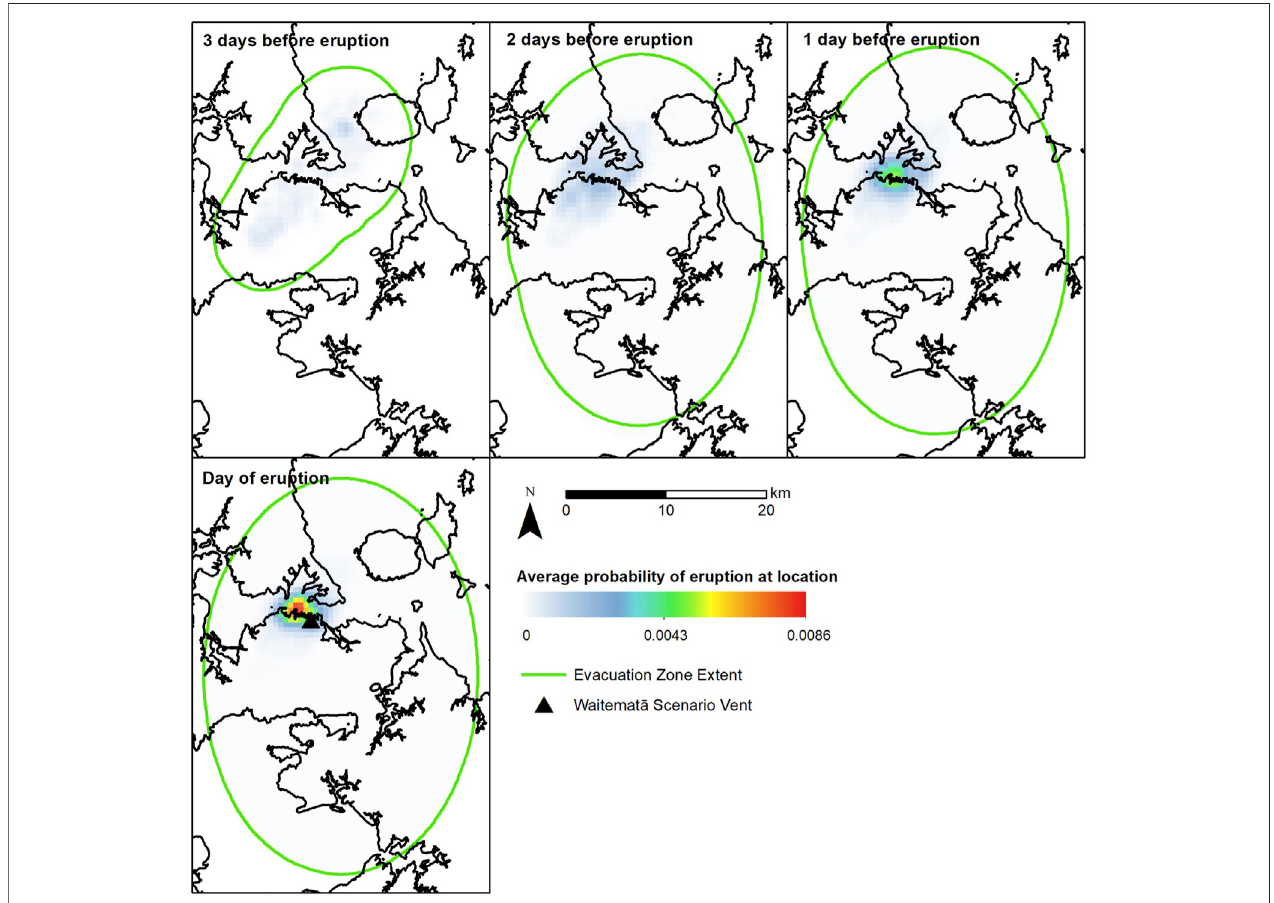
FIGURE 9 | Spatial distribution of absolute eruption probabilities for the Waitemat ā scenario from BETEF_AVF with a uniform prior vent model for selected days leading up to the eruption. The green contour encompasses the evacuation zone extent based on cost-bene fi t analysis.